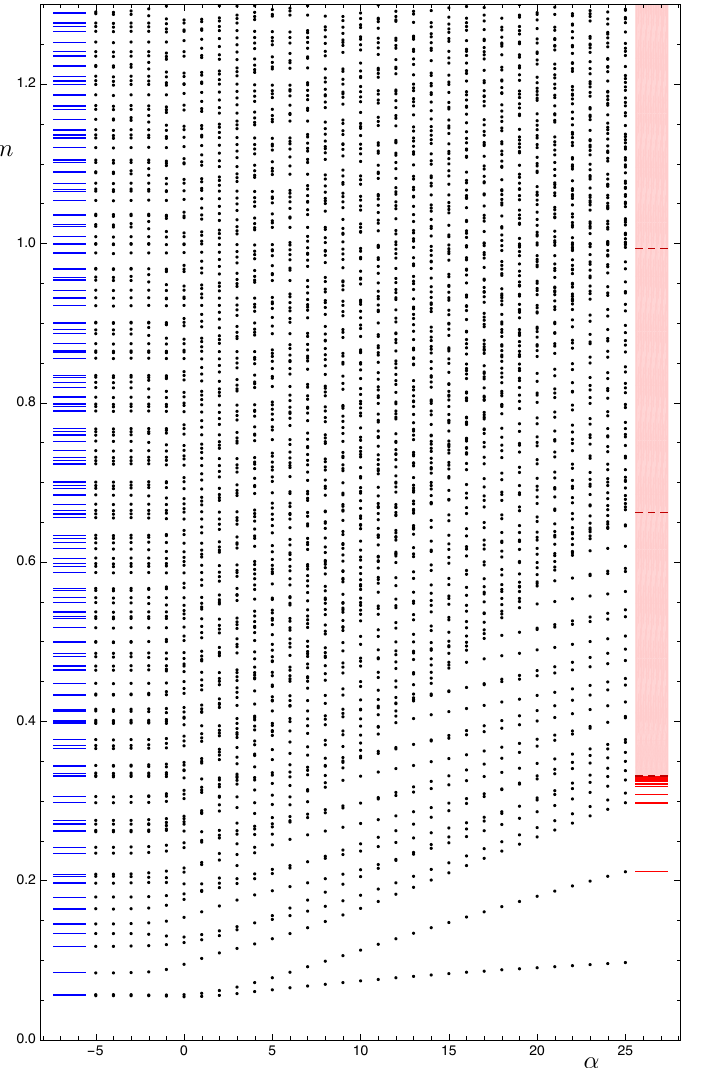
Figure 5 . The mass spectrum m of scalar modes as a function of the parameter (cid:11) characterizing the position along the baryonic branch of KS. By way of comparison, we show also the KS (in blue, far left) and CVMN limits (in red, far right), de(cid:12)ned as in appendix E. Notice that the latter has continuum thresholds (dashed lines), and that all calculations have been performed within the eight-scalar sigma-model truncation (PT